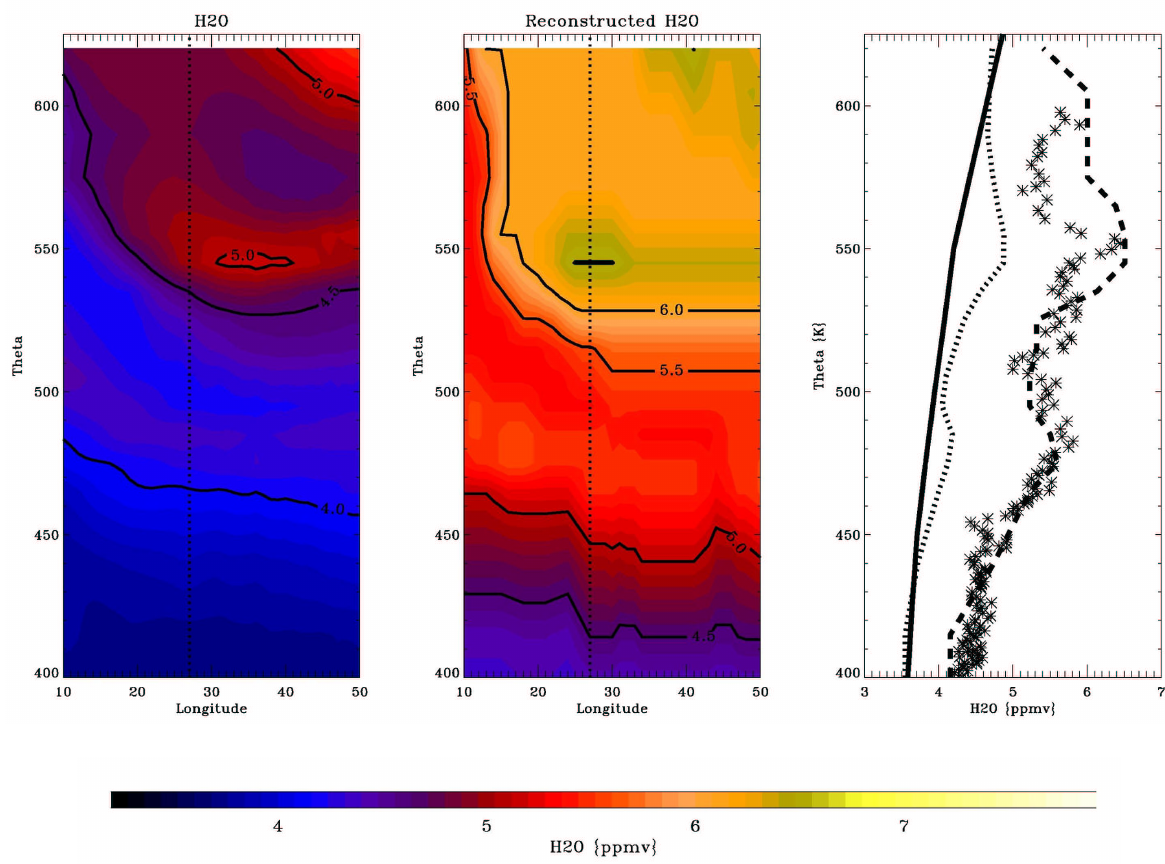
Fig. 8. Longitude-altitude cross-section for the transect on 23 February 2004 indicated in Fig. 3, showing ECMWF water vapour advected with MIMOSA (left) and reconstructed water vapour applying the empirical MPV-H 2 O correlation to MIMOSA PV fields (center). The right panel shows the profiles from ECMWF humidity analysis (black line), MIMOSA humidity reconstruction based on ECMWF humidity (dotted line), MIMOSA humidity reconstruction based on MPV correlation (dashed line), and as measured by FLASH (crosses).